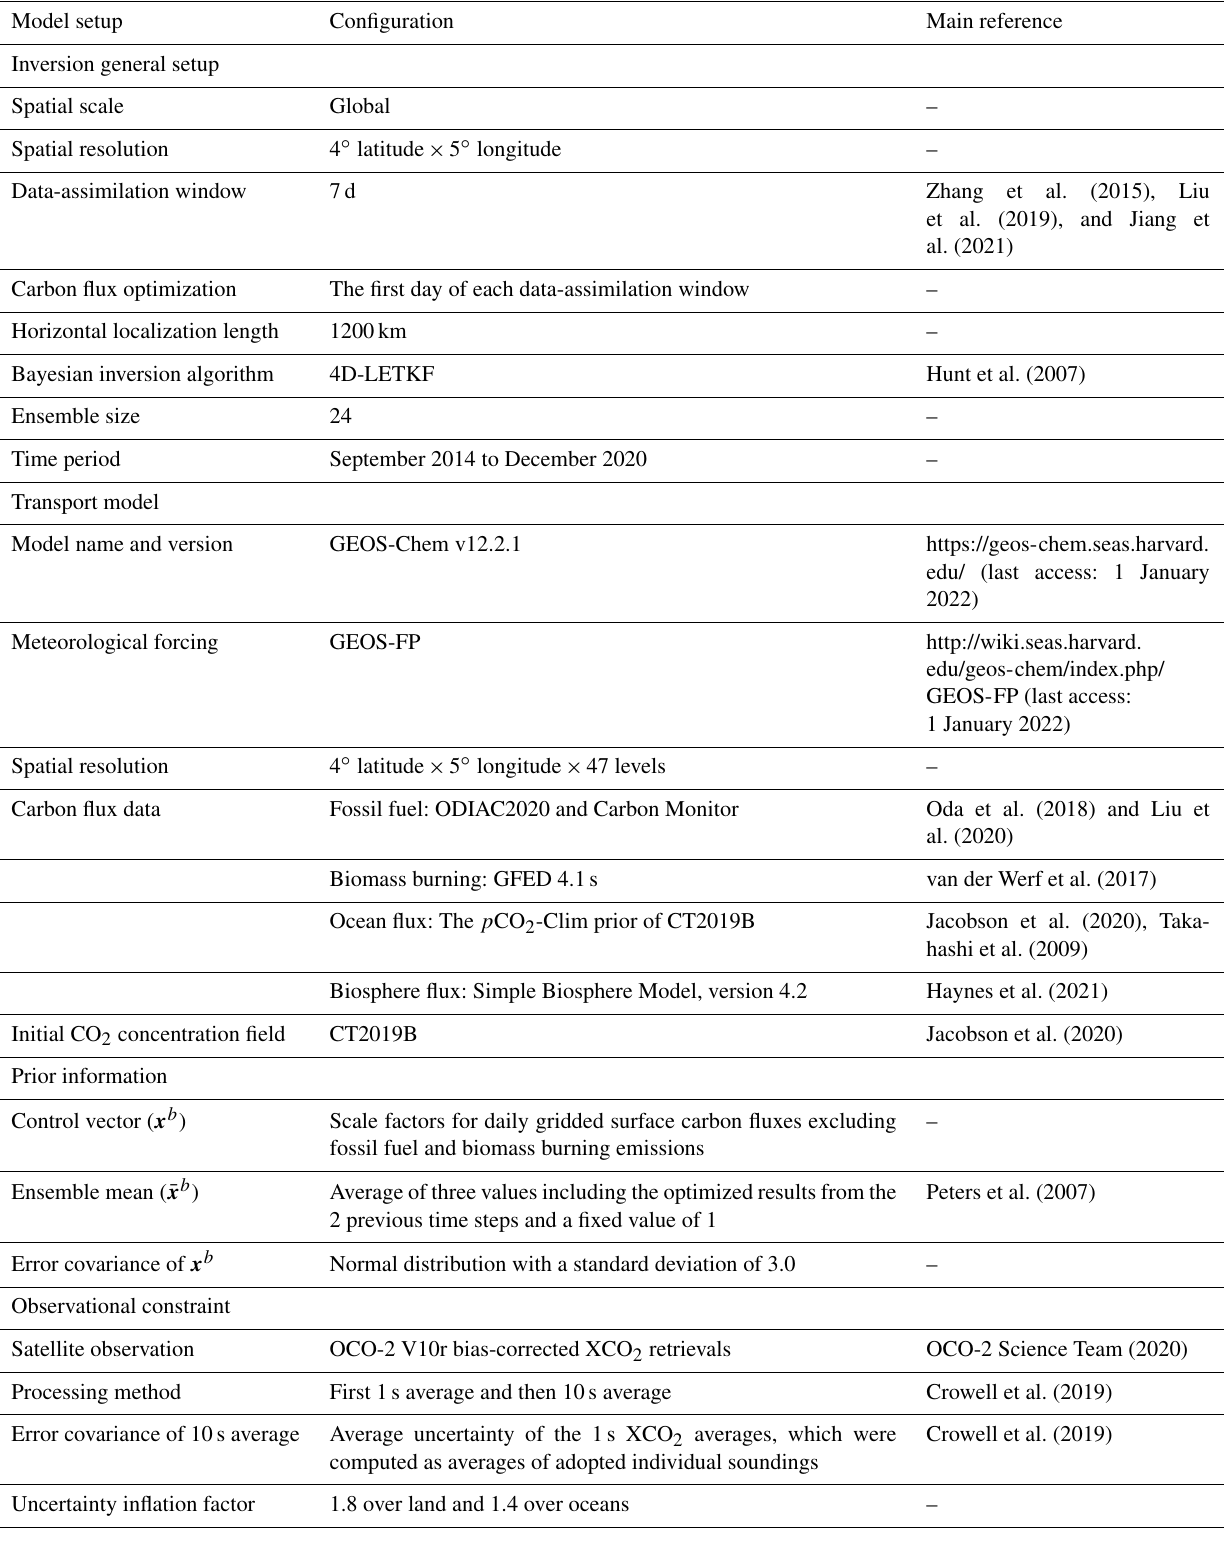
Table 1. Configuration of the atmospheric carbon inversion system developed in this